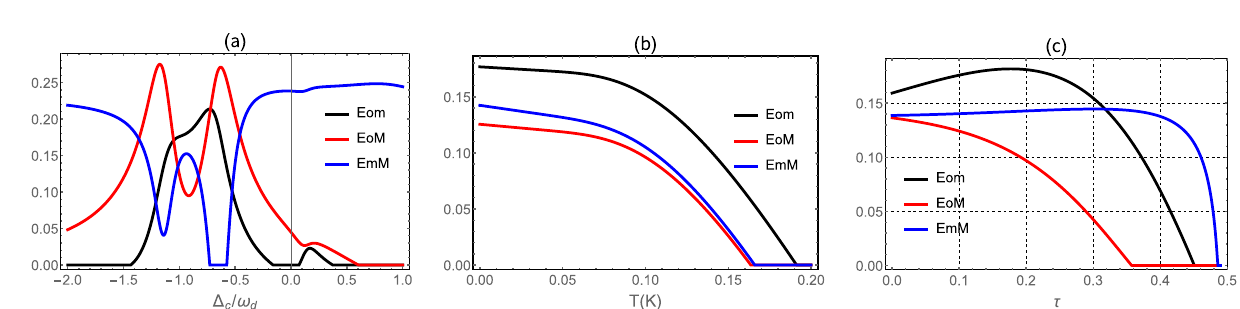
Figure 2. Plot of bipartite entanglement ( a ) Eom , ( b ) EmM , and ( c ) EoM versus detunings (cid:31) c and (cid:31) m with 0.1 and θ 0 . See text for the other parameters. τ = =